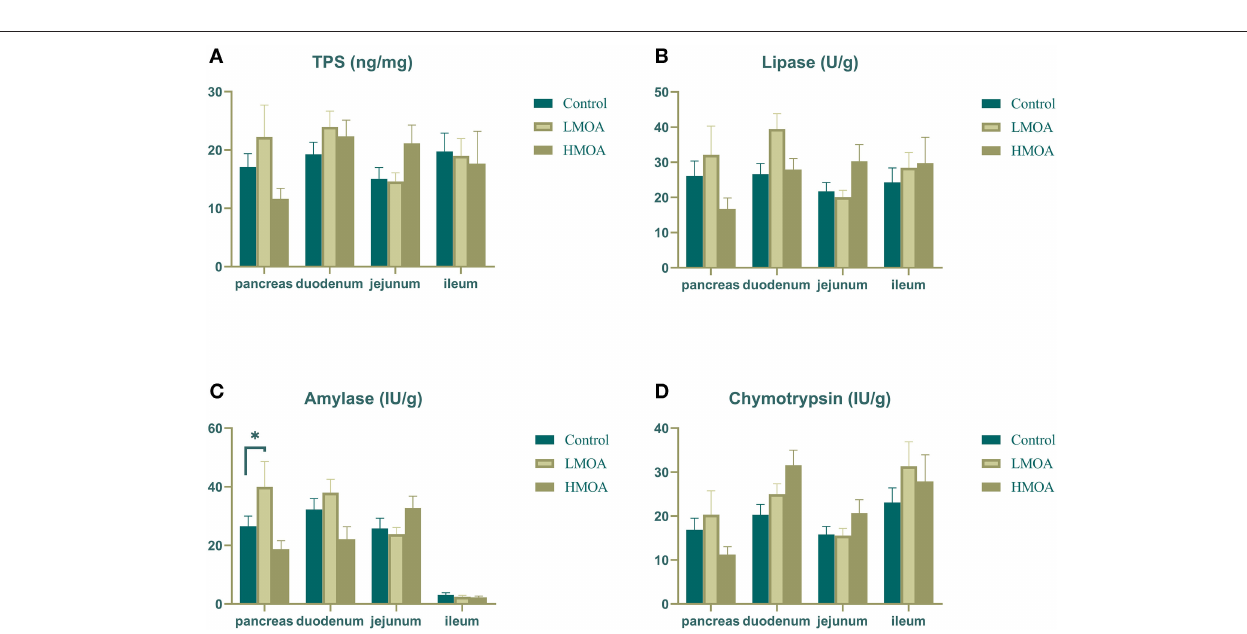
FIGURE 3 | The digestive enzyme activity of pancreas, duodenum, jejunum and ileum in 42 d-broilers as affected by dietary MOA supplementation. (A) Trypsin activity, (B) Lipase activity, (C) Amylase activity, and (D) Chymotrypsin activity. Control: a basal diet of corn-soybean meal with 0 mg/kg of mixed organic acid; LMOA: a basal diet with 3,000 mg/kg of mixed organic acids; HMOA: a basal diet with 6,000 mg/kg of mixed organic acids. Data are indicated as means ± SEM ( n = 8). Bar with the asterisk (*) level presented the degree of significant difference. * 0.01 < p < 0.05.